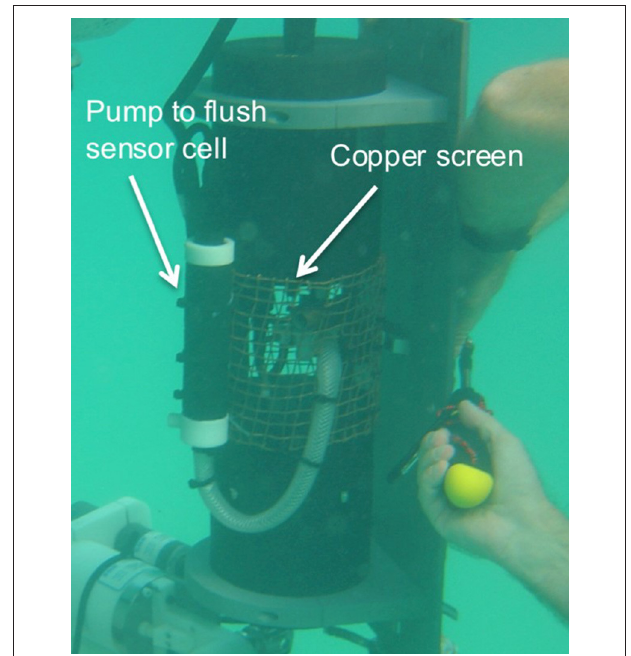
FIGURE 6 | A SAMI-CO 2 with an anti-fouling configuration. The membrane equilibrator ( Figure 1 ) is enclosed in a flow cell that isolates it from the seawater. Either a tributyl tin plug or a copper inlet tubing is used as antifouling agents to prevent fouling in the enclosed cell. The copper screen is used as a protective enclosure that also discourages biofouling around the sensor